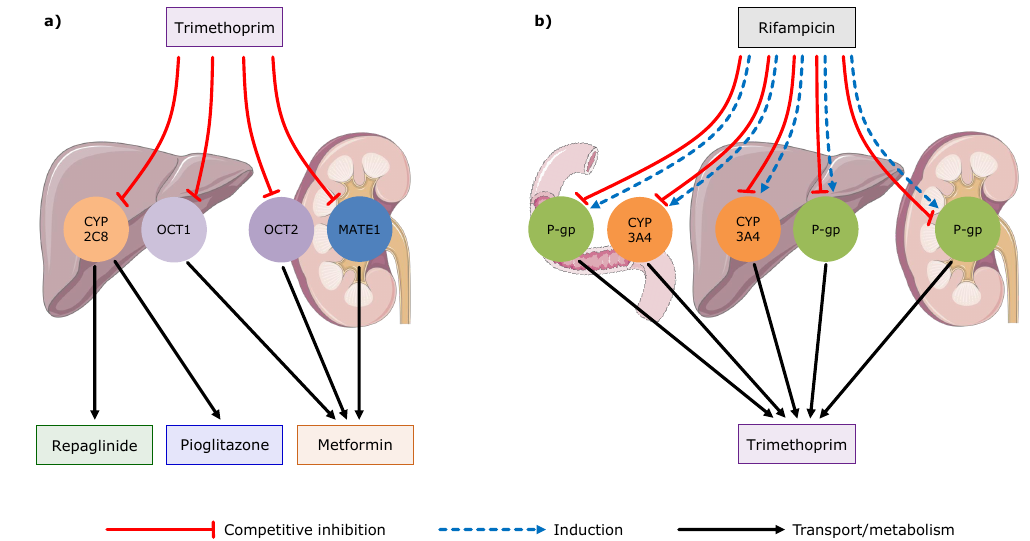
Figure 5. Trimethoprim drug–drug interaction (DDI) network. ( a ) Trimethoprim is a MATE1, OCT1, OCT2 and CYP2C8 inhibitor that impacts the pharmacokinetics of metformin, repaglinide, and